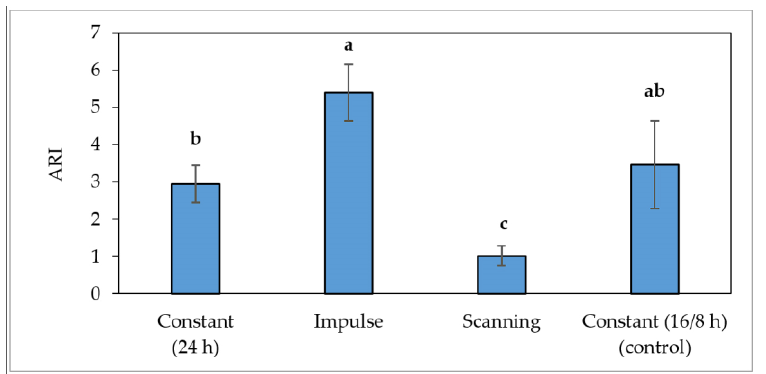
Figure 5. Anthocyanin content index (ARI) of lettuce plants on the 35th day of cultivation. Values represent mean SEM (n = 10). Letters indicate significant differences among treatment and control samples ( p < 0.05).